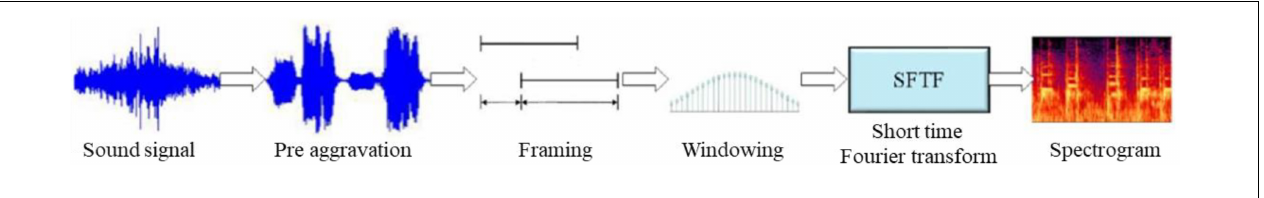
FIGURE 1 | Spectrogram